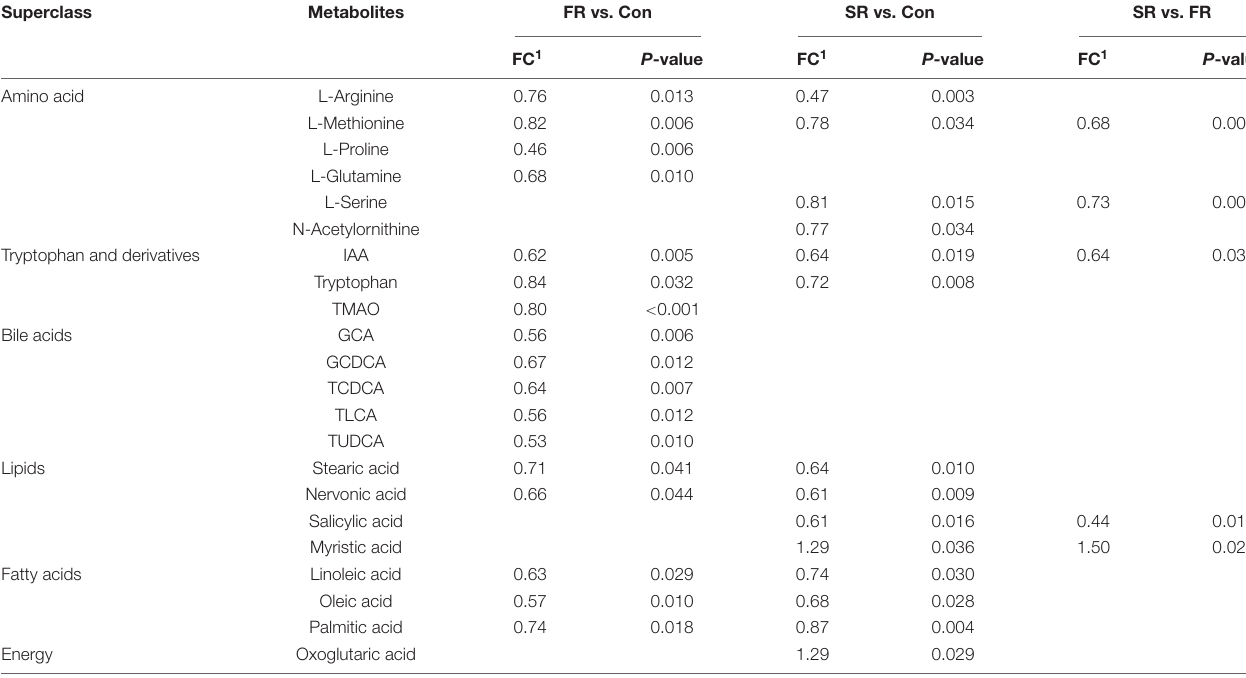
TABLE 2 | The significantly different serum metabolites between saline (Con) and fresh rumen fluid (FR), saline (Con) and sterilized rumen fluid (SR)